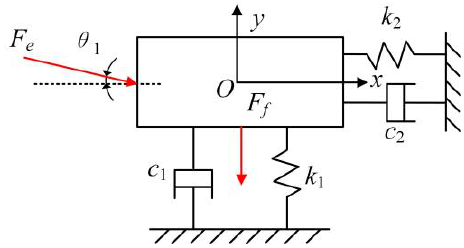
Figure 8. Movement process of blades in a single cycle when using hybrid biaxial fatigue testing device. a is hydraulic loader of flapwise, b is cross section of blade and fixture, c is hydraulic rod and vibration mass, d is push rod, d is push rod, e is rocker arm, f is foundation, g is hydraulic loader of edgewise.